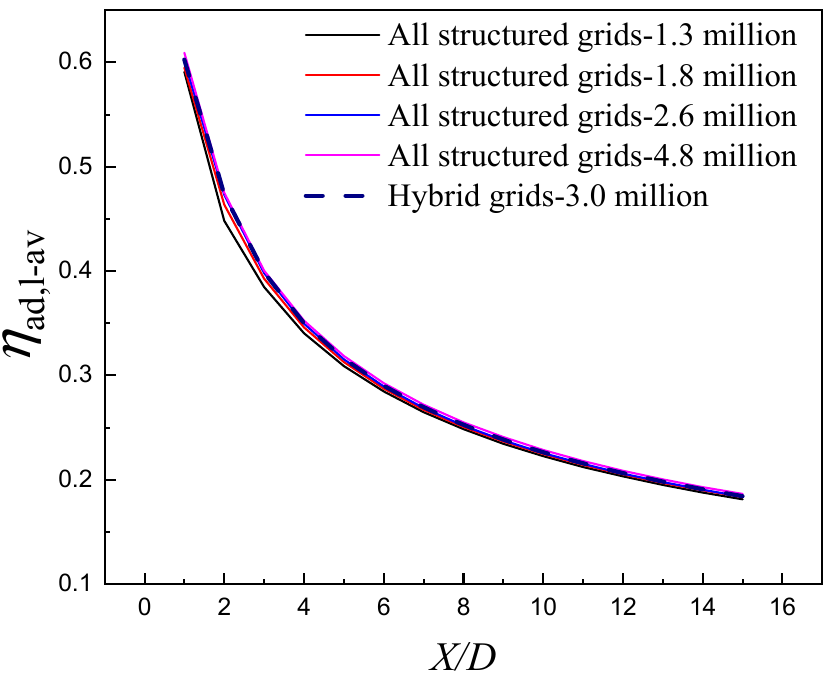
Figure 5. The grid-independent test for the SWR case under M = 0.5.